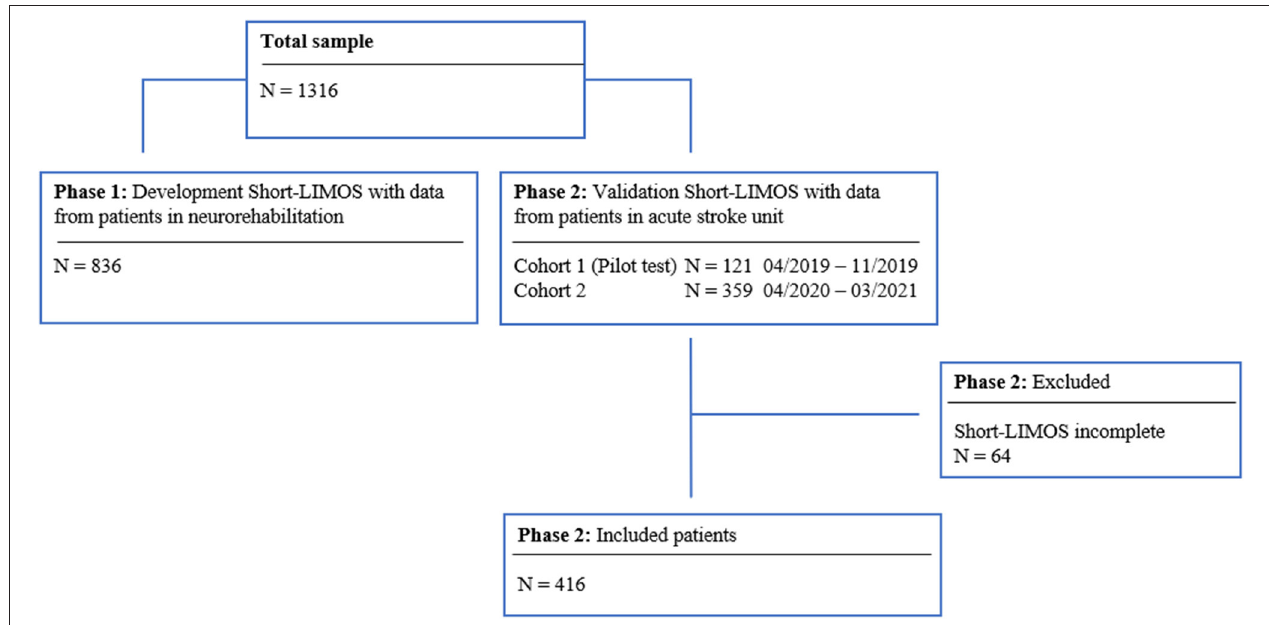
FIGURE 1 | Flow chart of the patient sample for the development and validation phase.